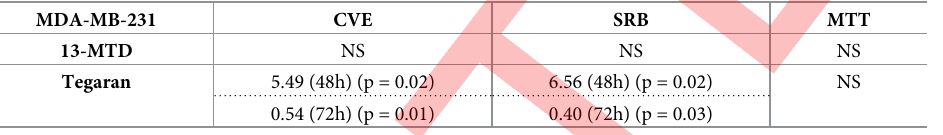
Table 5. MDA-MB-231 cell line IC50 concentrations for 13-MTD and Tegaran according to CVE, SRB and MTT assay (NS- No significant).